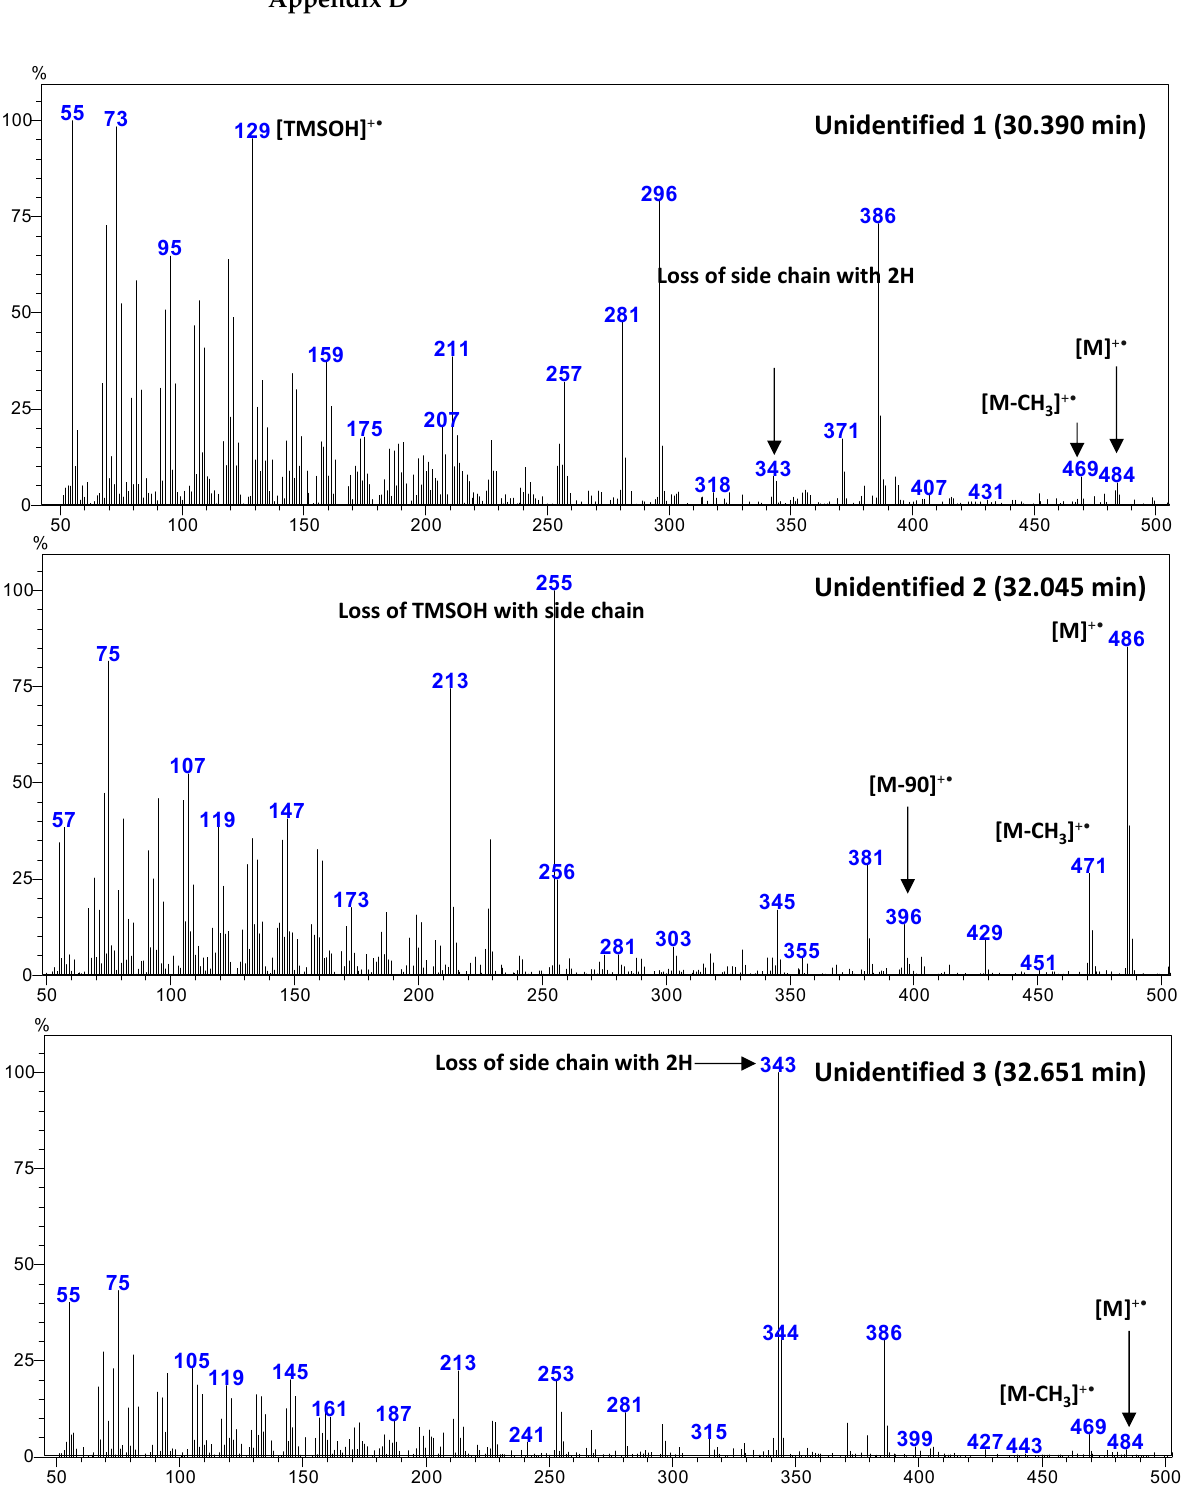
Figure A4. The gas chromatography (GC)-mass spectra of unidentified sterols (from the celery seeds).